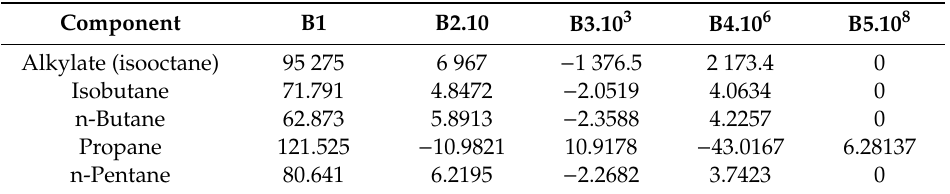
Table 3. Molar heat capacities. Coe ffi cients obtained from [49] for alkylate, from [50] for propane, and from [51] for butanes and pentane.